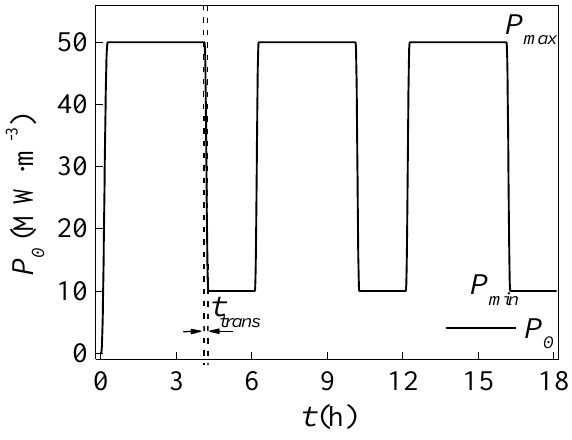
Figure 3. Power density of a cyclic thermal load.